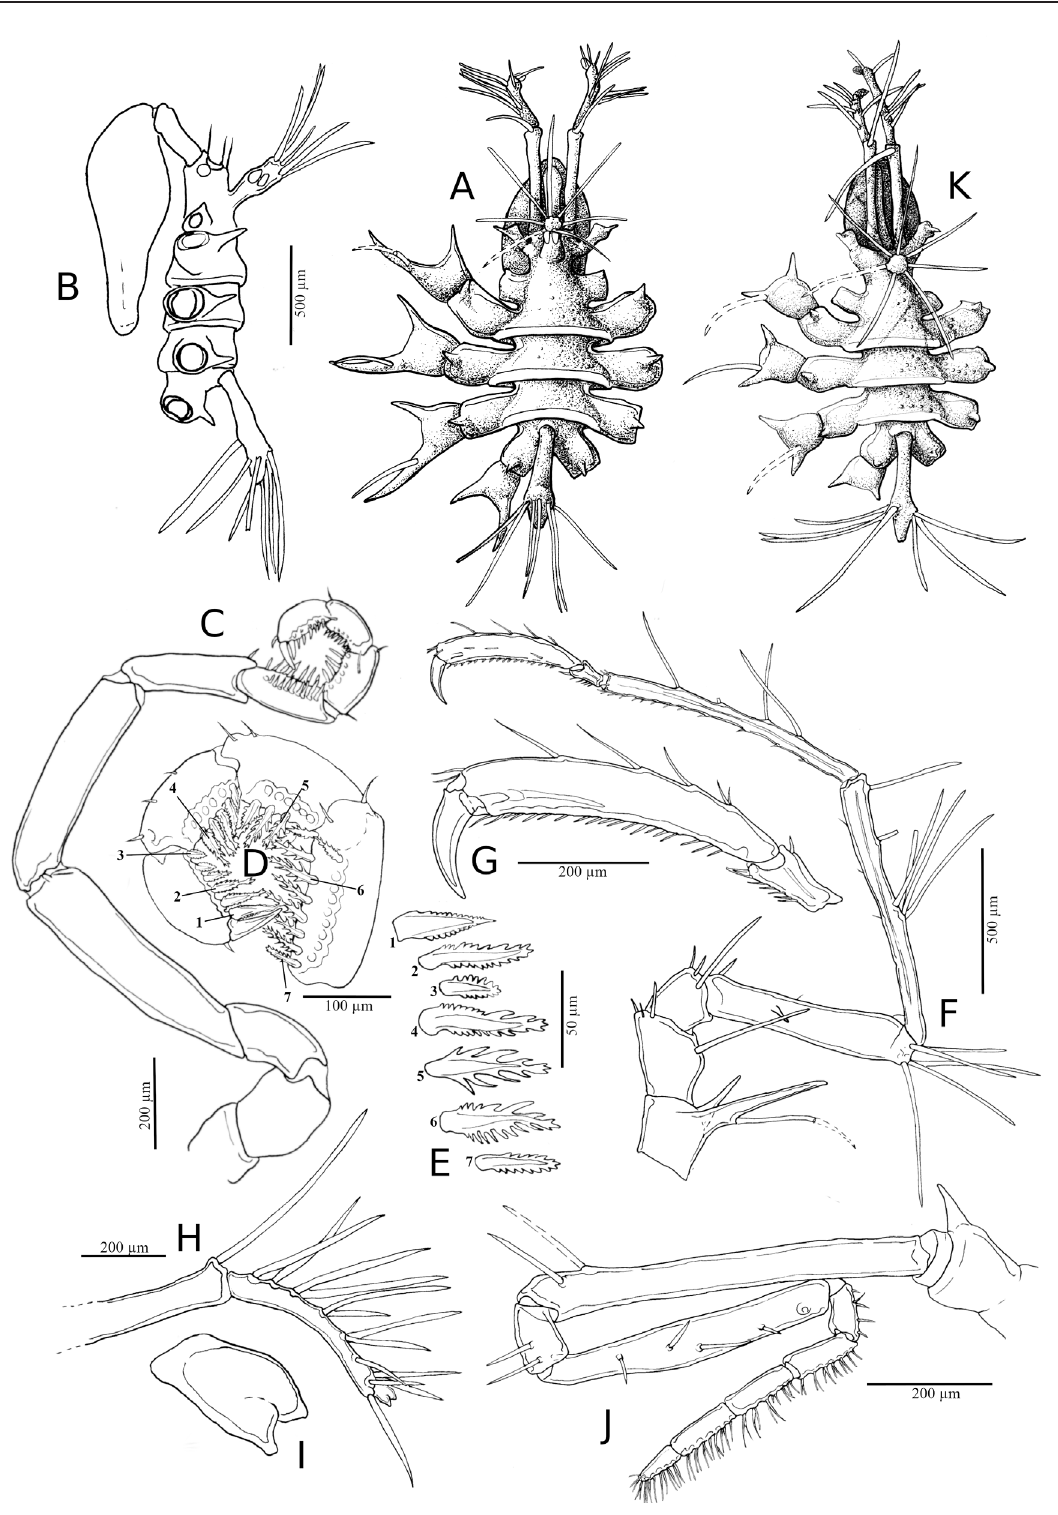
Fig. 9. Comparison between Eurycyde kaiouti sp. nov. (A–J) and E. raphiaster Loman, 1912 (K). A–J . Holotype, ♂, MNHN-IU-2016-1129. K . ♂, MNHN-IU-2016-818. A . Body, dorsal view. B . Body, lateral view (same scale as A). C . Oviger. D . Oviger strigilis. E . Pointed teeth of oviger strigilis. F . Third leg. G . Tarsus and propodus of third leg. H . Chelifore. I . Chela bud. J . Palp. K . Body, dorsal view (same scale as